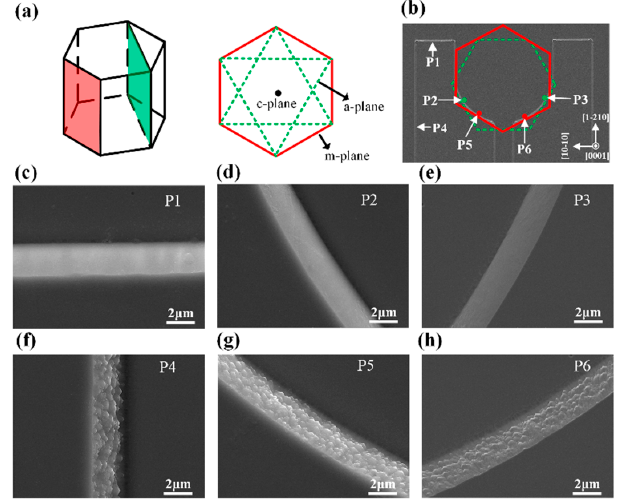
Figure 4. ( a ) Schematic of the wurtzite structure GaN unit cell and its projection in the c -plane. ( b ) SEM images of Type-I LED chips, the projection was incorporated to show the exposed m -plane and a -plane. ( c – h ) The SEM images at marked positions: ( c ) P1; ( d ) P2; ( e ) P3; ( f ) P4; ( g ) P5; and ( h ) P6.